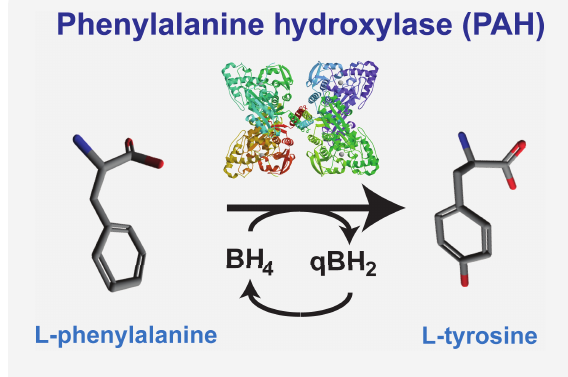
Figure 1. Phenylalanine hydroxylase (PAH) reaction and Phenylke- tonuria (PKU). Phenylalanine hydroxylase is a cytoplasmic iron and molecular oxygen-requiring homotetramer that catalyzes the conver- sion of L-phenylalanine to L-tyrosine in a reaction that utilizes the reduced pterin cofactor, tetrahydrobiopterin (BH 4 ). The oxidized pterin, quinonoid dihydrobiopterin (qBH 2 ), is enzymatically reduced back to BH 4 and recycled to support continued Phe hydroxylation in liver. In recessively-inherited phenylketonuria (PKU), PAH activity is diminished or absent. PAH defi ciency leads to accumulation of L-phenylalanine, relative L-tyrosine defi ciency, and enzymatically catalyzed deamina- tion of L-phenylalanine to the phenylketone, phenylpyruvic